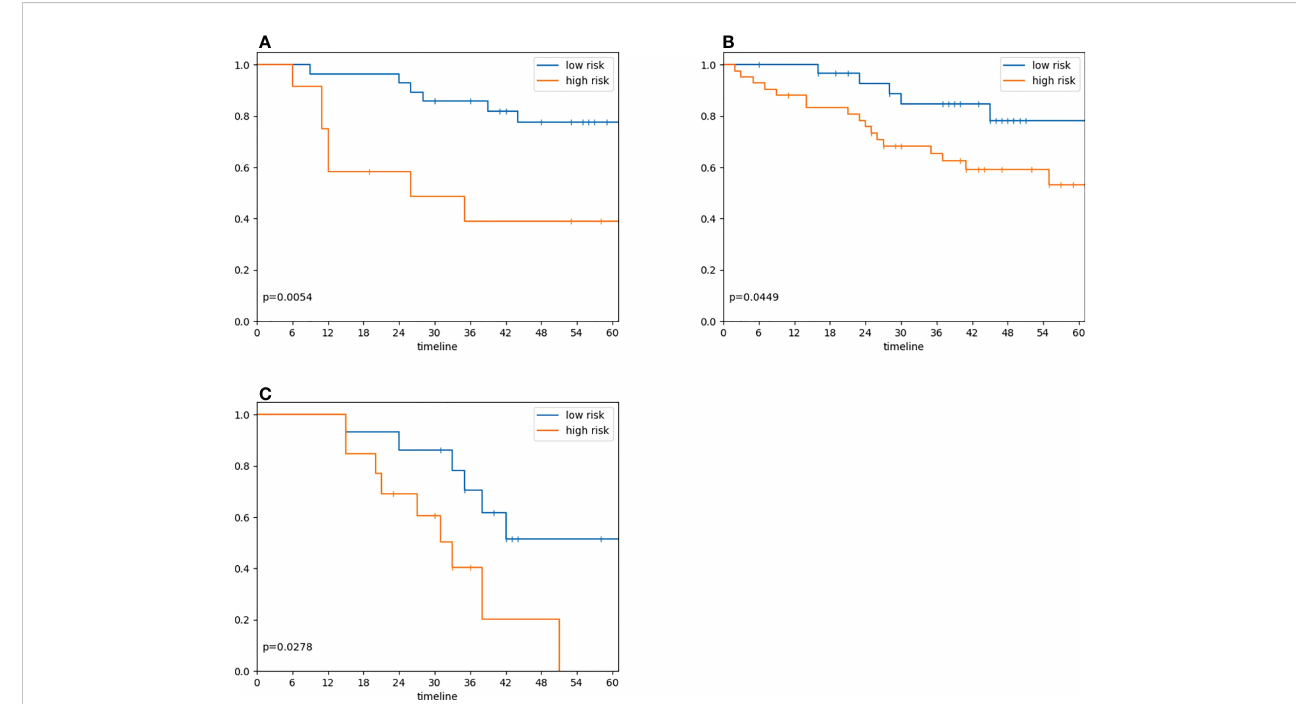
FIGURE 4 Radiomic signature risk group associations with overall survival. (A) Overall survival in 40 patients in the validation cohort who underwent preoperative Gd-DO3A-butrol-enhanced MRI, strati fi ed by the radiomic signature model trained on Gd-EO3A-butrol training cohort (model score dichotomization threshold=0.5; log-rank test, p=.005). (B) Overall survival in 72 patients who underwent preoperative Gd-EOB-DTPA enhanced MRI, strati fi ed by radiomic signature model (Maximally Selected Rank Statistic threshold=0.30; log-rank test, p=.04) (C) Overall survival in 28 patients who underwent